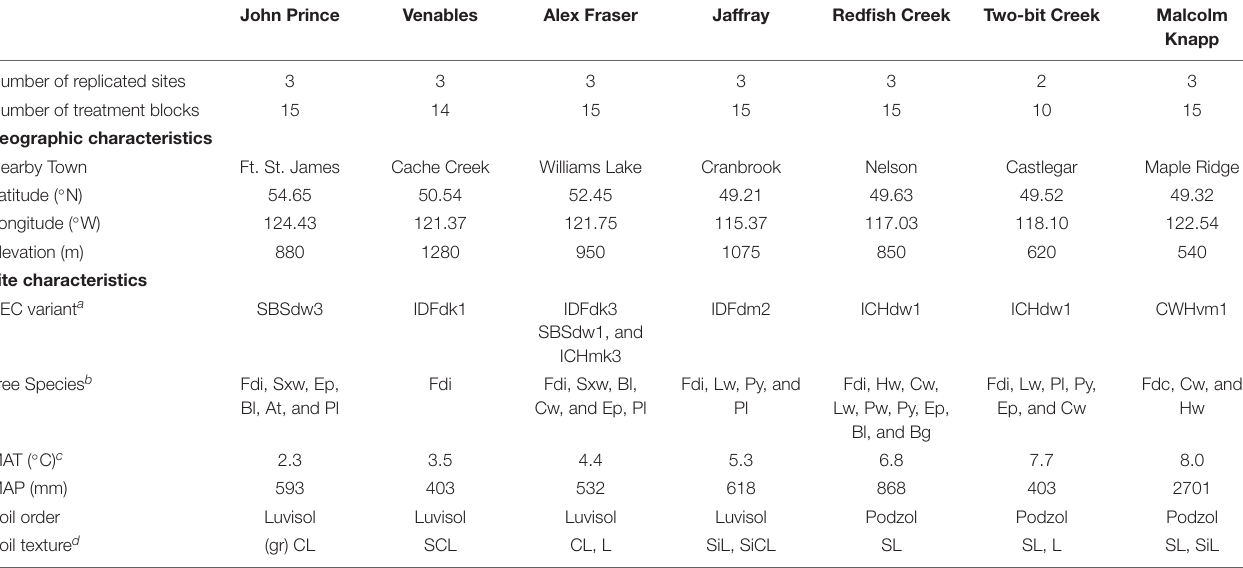
TABLE 1 | Site characteristics of the seven forest locations across British Columbia, Canada.